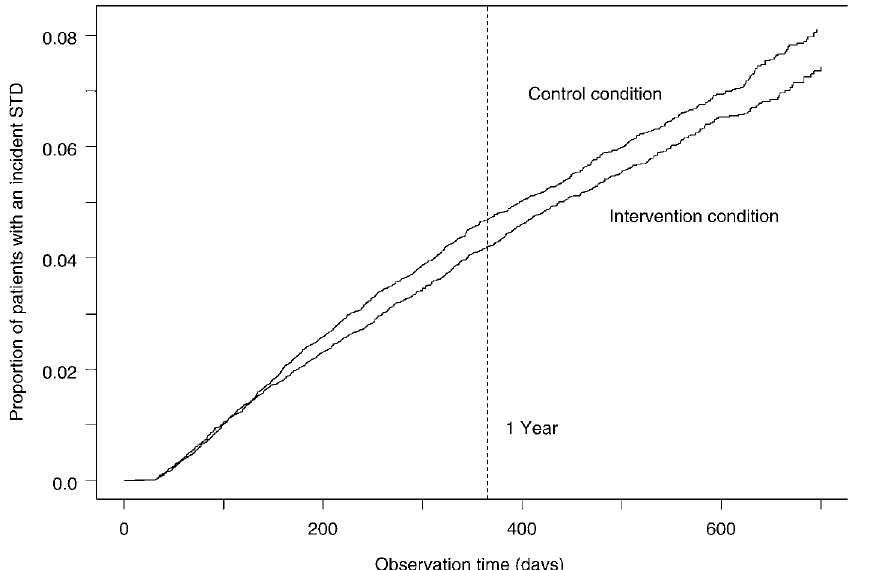
Figure 2. Laboratory-Confirmed Infection among Patients at Sexually Transmitted Disease Clinics in Three U.S. Cities, December 2003 through August 2005, by Study Condition